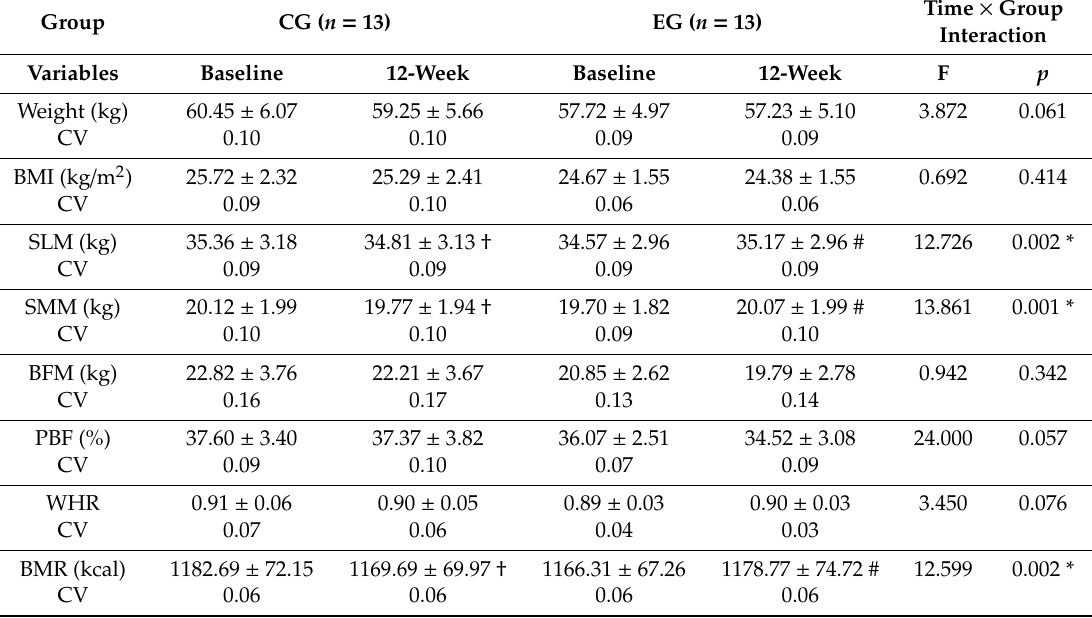
Table 2. The changes in body